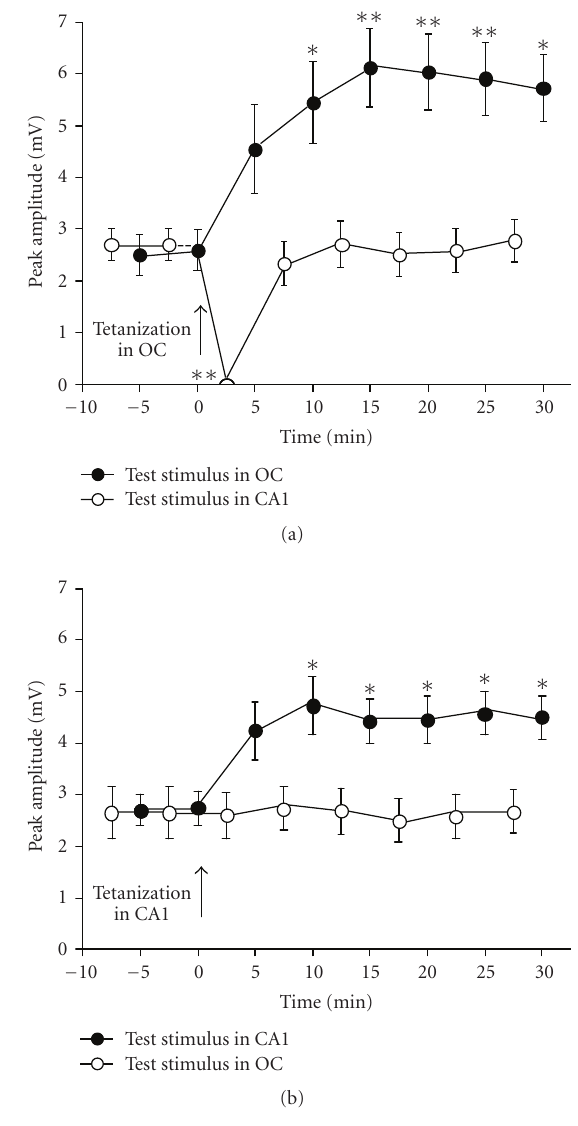
Figure 2: Time-course of LTP induced in the medial entorhinal cortex of 55–60-day-old normal eutrophic rats by applying tetaniz- ing stimulation to the occipital cortex (a) or to the ventral CA1 hippocampal region (b). The arrow indicates time of application of the tetanizing stimulus. N = 8 rats in all groups. Values are means ± SEM of peak-to-peak amplitudes, 30 responses averaged per rat. Note the occurrence of homosynaptic, but not heterosynaptic potentiation. One-way ANOVA followed by Dunnett’s multiple comparisons test indicated significant intragroup di ff erences in peak-to-peak amplitudes ( ∗ P < . 05, ∗∗ P < . 01) when comparing post-tetanizing values with the last pretetanizing basal point (at 0 minute), excepting for block 2.5–5 minutes (a), where significant inhibition ( ∗∗ P < . 01)